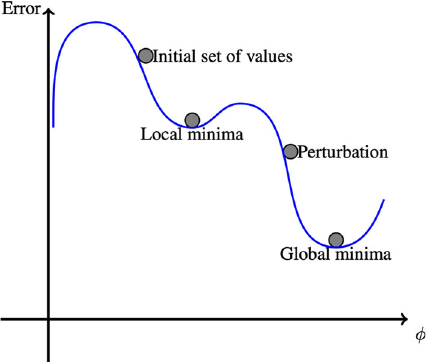
Fig. 4 In a schematic view, the SA algorithm starts at an arbitrary point in the parameter space of the Error function, then it lets to find in a random manner the best solution leading to a local minimum. Once the local minimum is reached, the algorithm shall find alternative paths that find a better minimum by perturbing the solution with a probability P [ (cid:15) Error] avoiding getting stuck in a local